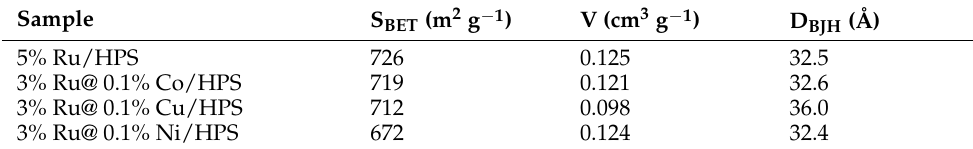
Figure 4. Ruthenium and doped ruthenium/HPS catalysts adsorption–desorption isotherms compilation. Table 2. BET specific surface area (SBET), pore volume (V) and average pore diameter (DBJH) for doped and non-doped ruthenium/HPS catalysts.